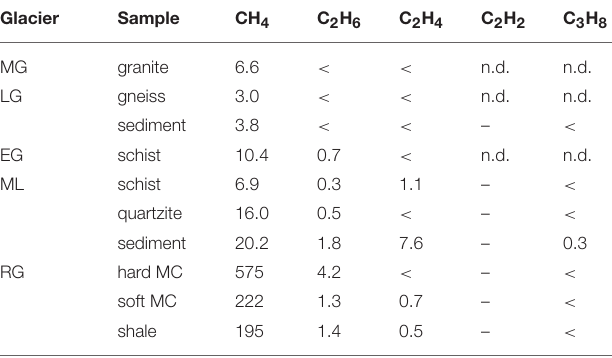
( Figure 3A ) and H 2 :CO 2 ( Figure 3B ) ratios compared with the wider population of rocks. The H 2 /CO 2 and C 2 H 6 /CH 4 relationships were highly linearly correlated for all other rocks (R 2 of 0.86 and 0.93, respectively) when ML sediment was not